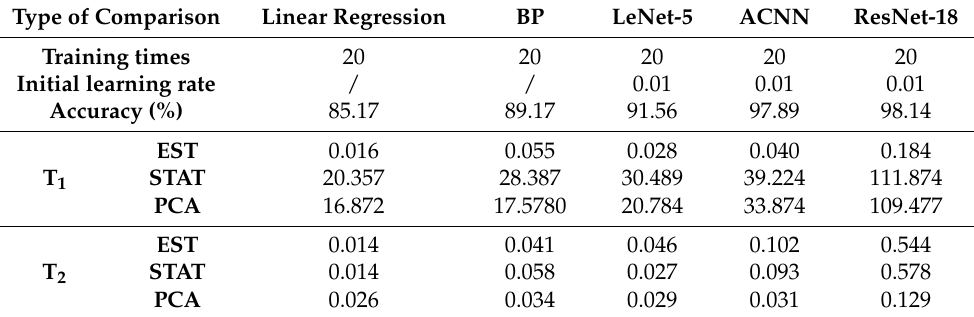
Table 2. Accuracy of different models and time spent modeling and generating samples. Type of